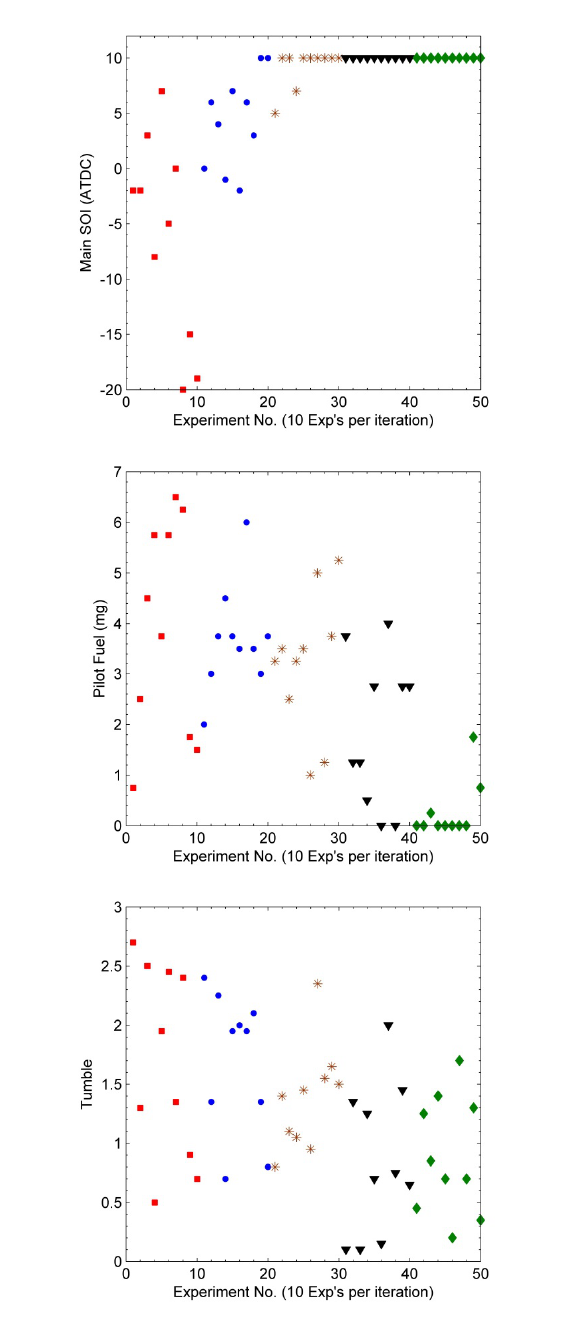
Fig. 12: Evolution of design variables. Table 6: Comparison of operating conditions at initial and optimum